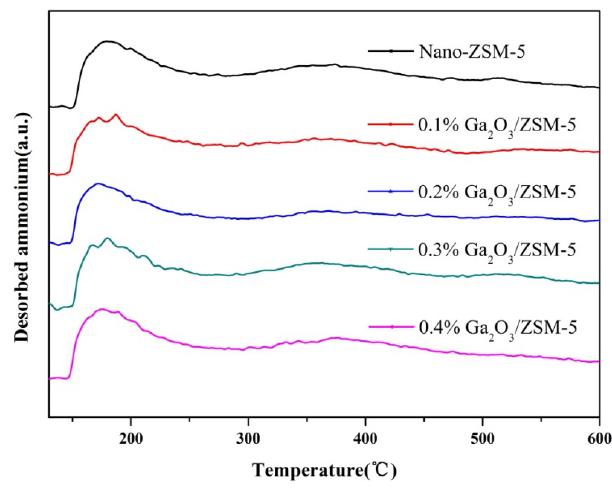
Figure 6. NH 3 -TPD profiles of x % Ga 2 O 3 /ZSM-5( x = 0, 0.1, 0.2, 0.3, 0.4).